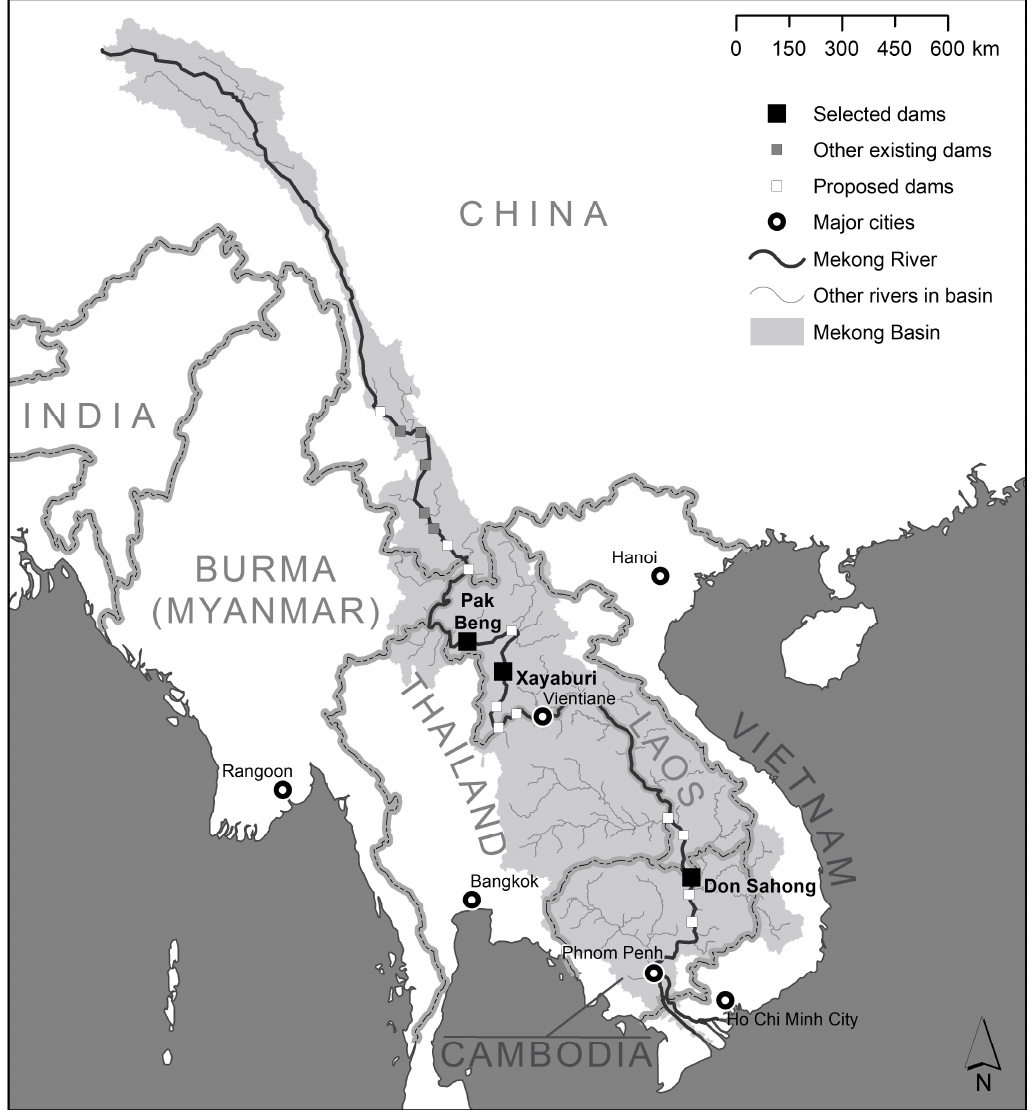
Figure 1. Map of Mekong River basin showing existing dams and ongoing hydropower projects mentioned in the article.